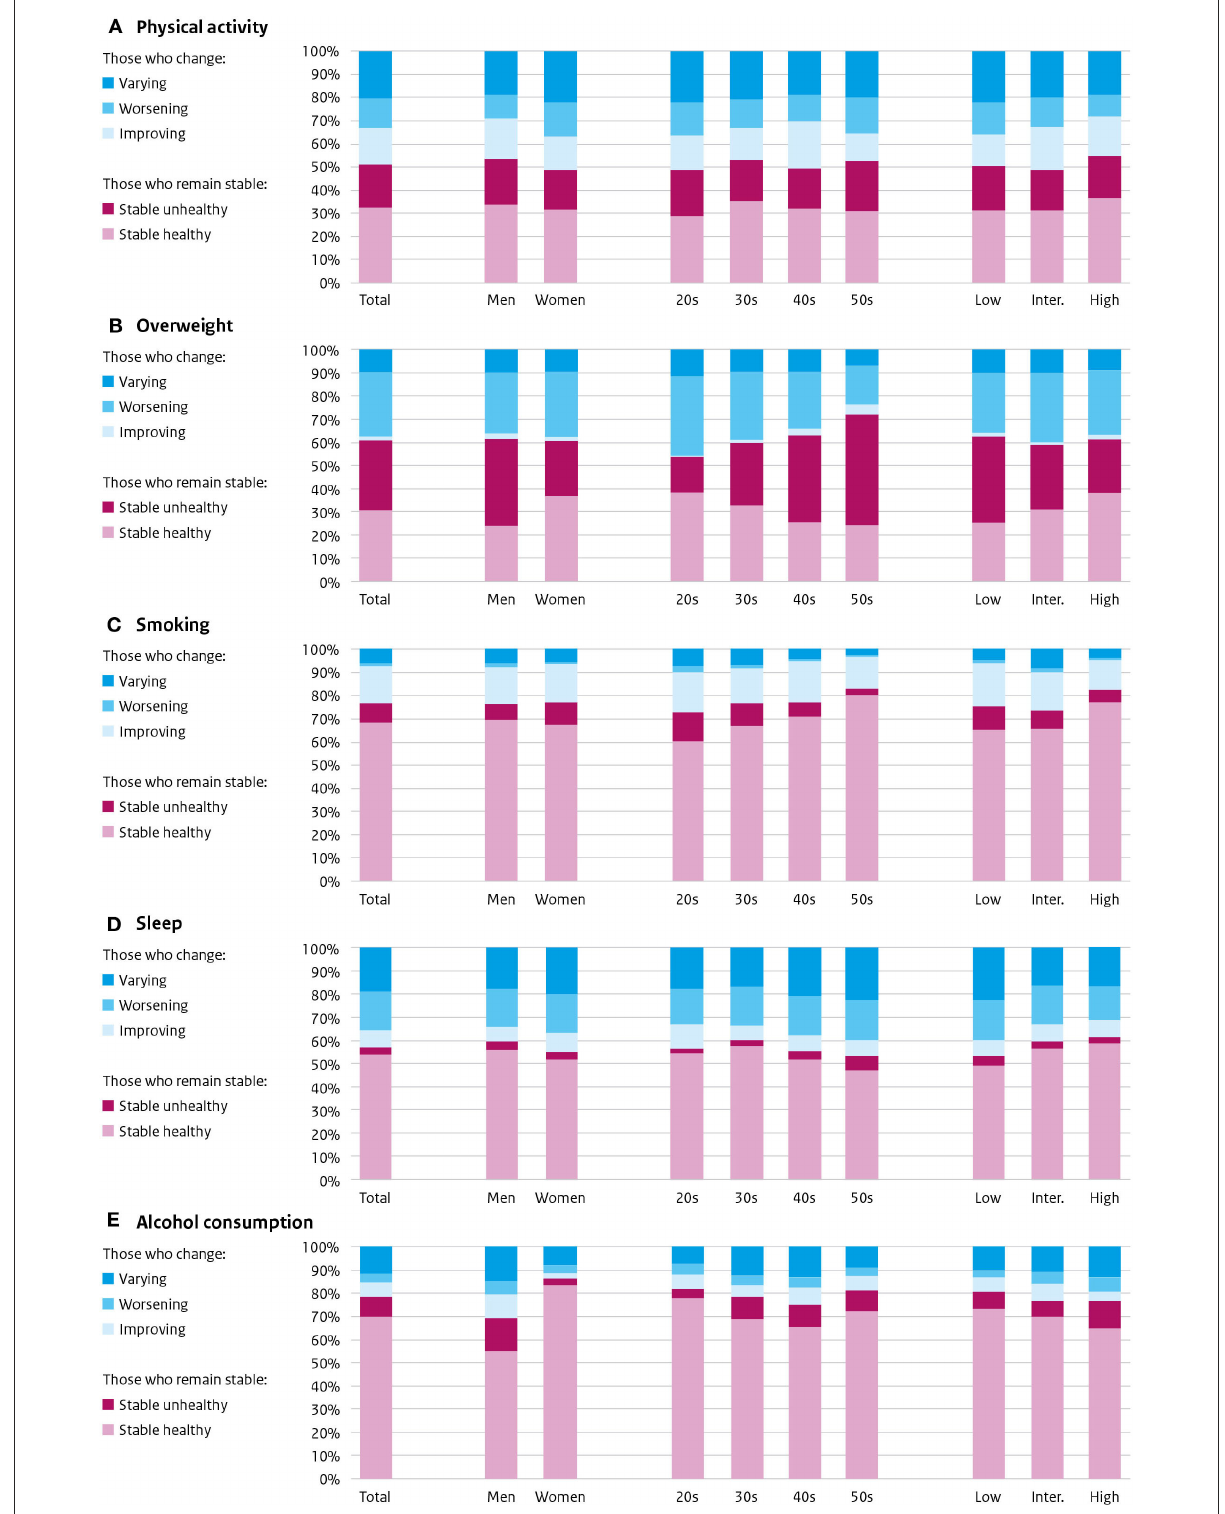
FIGURE3 Individual changes over 25 years in (A) physical activity, (B) overweight, (C) smoking, (D) sleep, and (E) alcohol consumption: those who remain stable (stable healthy or stable unhealthy) and those who change (improve, worsen or vary). By sex, 10-year generation, and educational